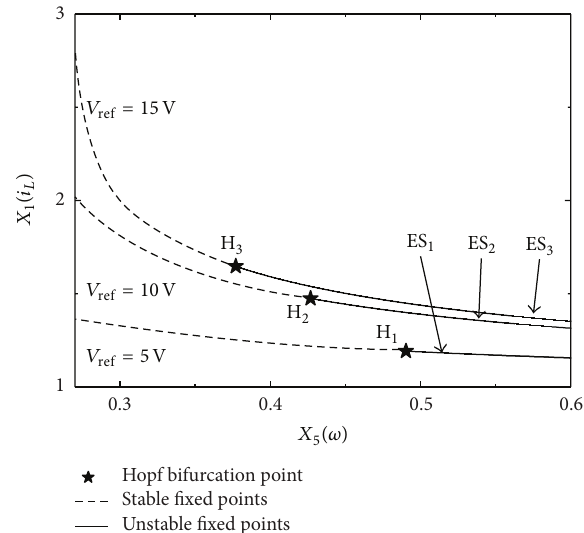
Figure 9: Transient fixed points curves (ES 1 , ES 2 , and ES 3 ) with the = 5 V, 10 V, 15 variation of 𝑋 5 (𝜔) at 𝑉 ref